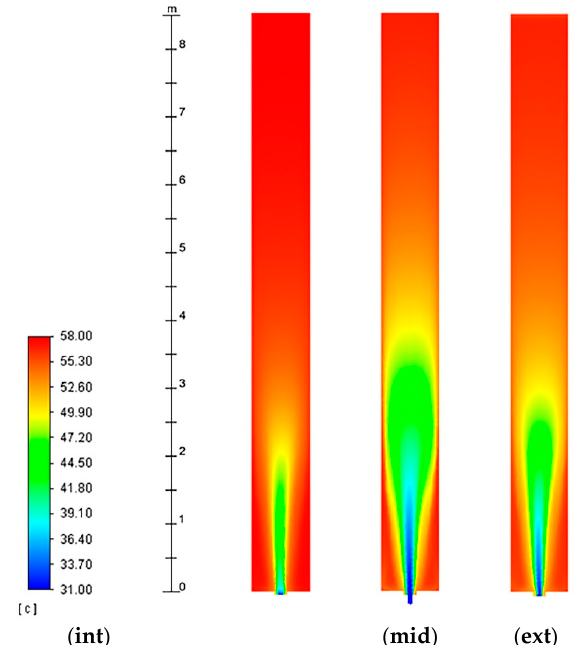
Figure 15. Temperature profile inside the naturally ventilated cavity at 4:00 p.m., plotted on the internal ( int ) and external ( ext ) surfaces of the cavity and on another surface ( mid ) at half its thick- ness.